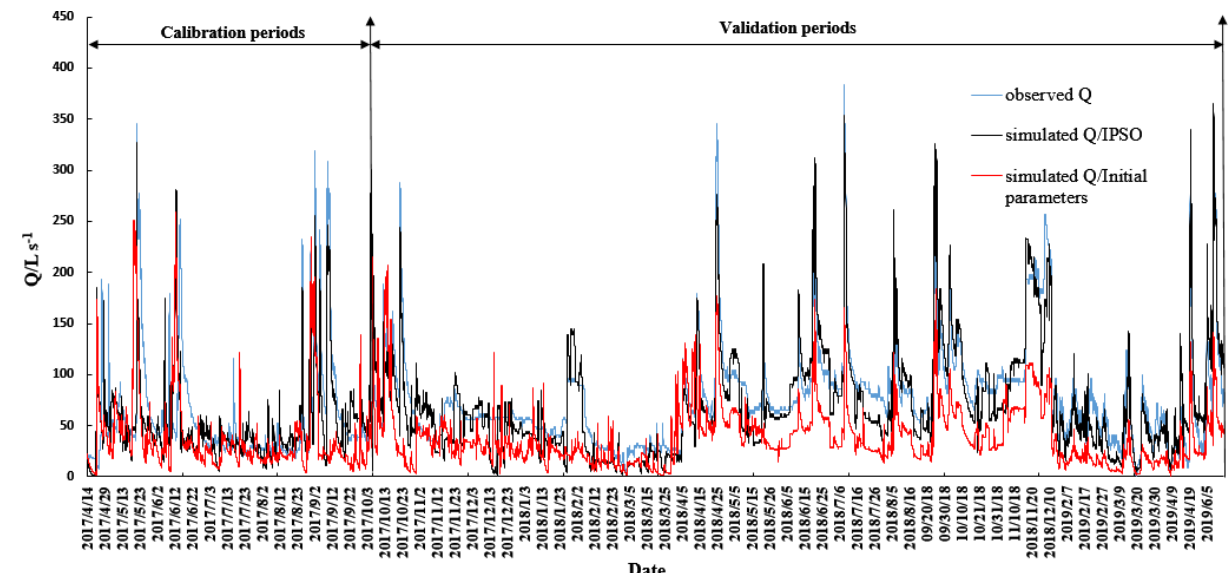
Figure 6. Flow simulation results of the QMG model based on parameter